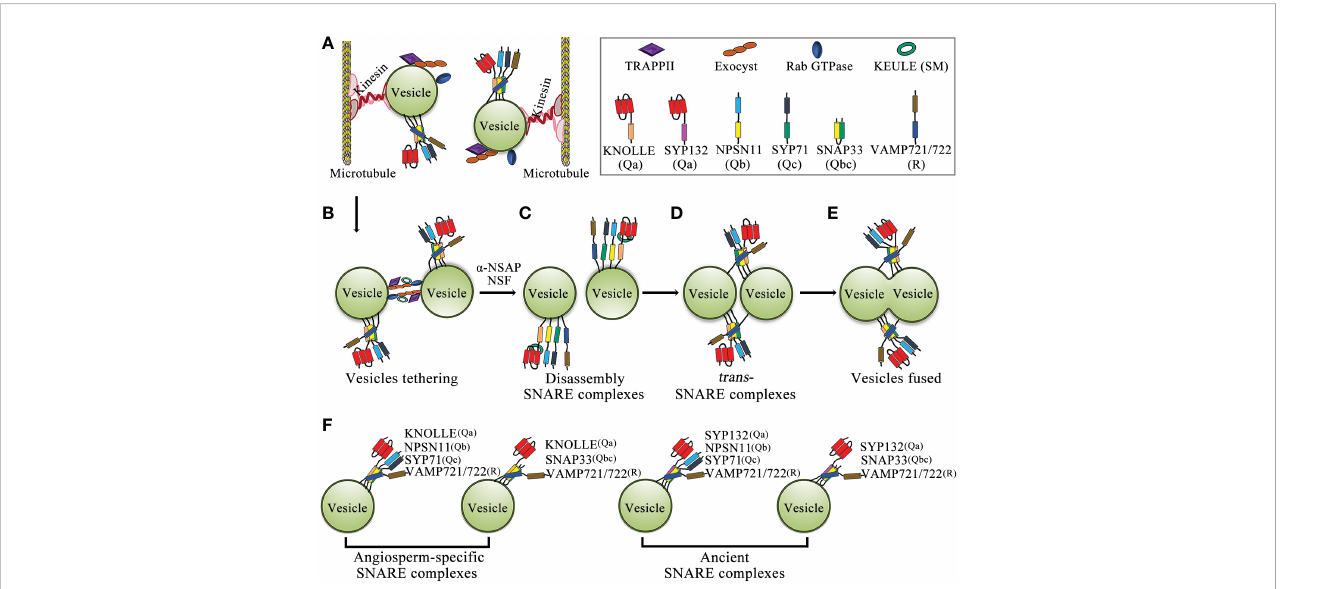
FIGURE 2 Schematic model of membrane-vesicle fusion during cytokinesis. (A) Vesicles carry Rab GTPase, two types of tethering complexes, TRAPPII and exocyst, and the KNOLLE-containing cis -SNARE complex through kinesin transport along microtubules to the plane of cell division. (B) Rab GTPases promote the tethering of two adjacent vesicles by tethering complexes (TRAPPII and exocyst). (C) The cis -SNARE complex is disassembled by NSF-ATPase and a - SNAP, and the Qa-SNARE KNOLLE interacts with the Sec/Munc18 protein KEULE to keep the KNOLLE in an open conformation. (D) KNOLLE interacts with SNARE partners of adjacent vesicles to form trans -SNARE complexes. (E) Two adjacent vesicles fused together. (F) Model of the SNARE complex in cytokinesis. The cytokinesis-speci fi c Qa-SNARE KNOLLE forms two types of SNARE complexes. In addition, the evolutionarily ancient Qa-SNARE SYP132 forms two types of SNARE complexes. Abbreviations: SM, Sec1p/Munc18; a -SNAP, a -soluble NSF attachment protein; and NSF, n-ethylmaleimide- sensitive